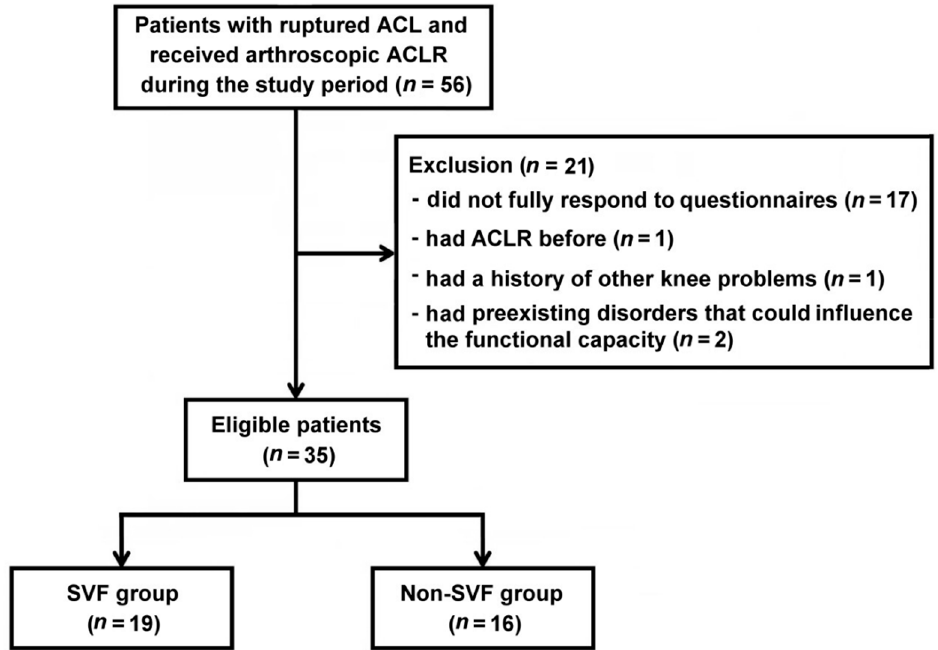
Figure 1. Patient enrollment flowchart: ACL, anterior cruciate ligament; ACLR, anterior cruciate ligament reconstruction; SVF, adipose stromal vascular fraction.